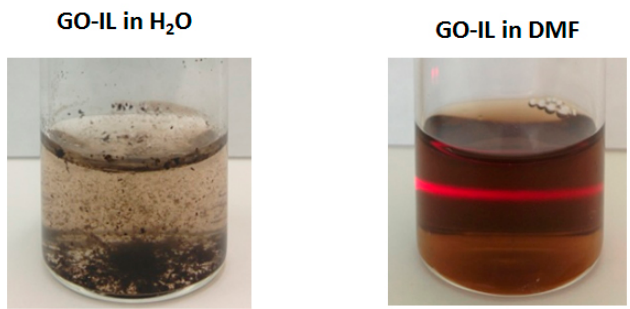
Figure 6. Dispersibility of GO-IL in water and DMF ( c = 0.5 g / L at room temperature (RT)). Note that GO-IL cannot disperse in water even after 8 h of ultrasonication treatment.